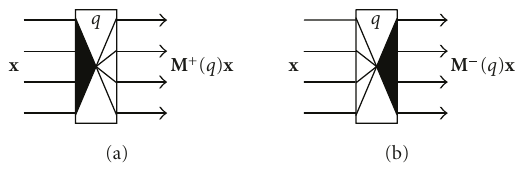
Figure 4: Graphical symbols for the quaternion multipliers whose coe ffi cient q is (a) the left multiplication operand and (b) the right multiplication operand, respectively.